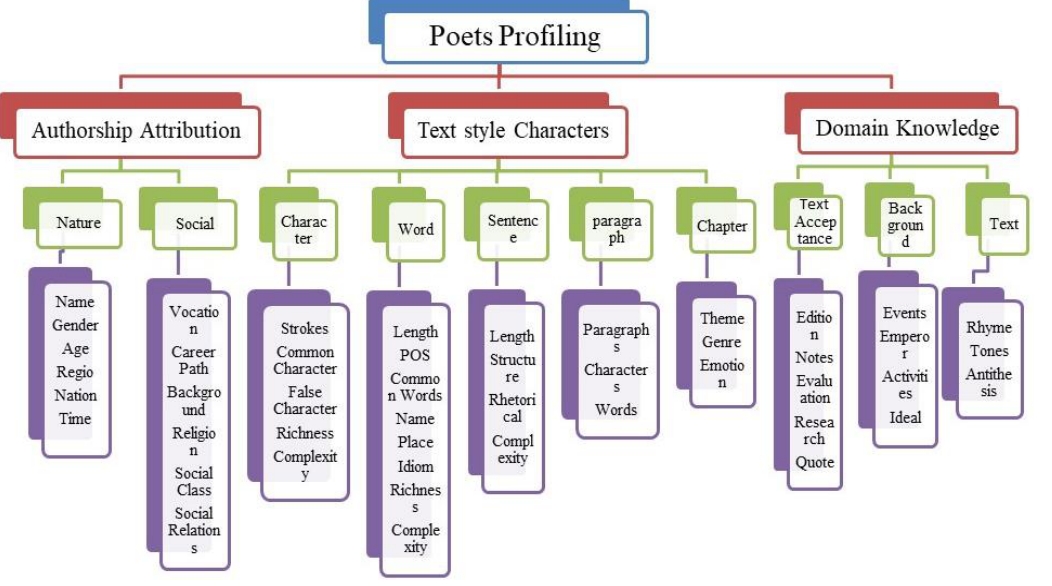
Figure 6. Overall view of the poets’ profiling framework.